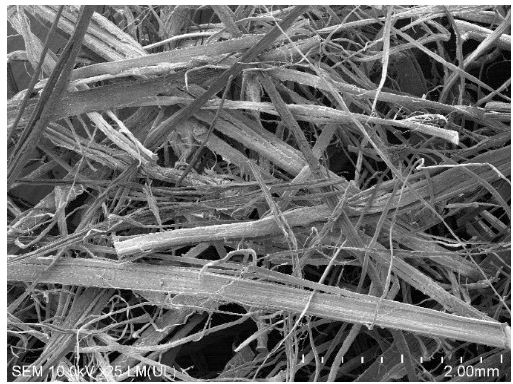
Figure 1. SEM image of hemp fibers (HF) structure.